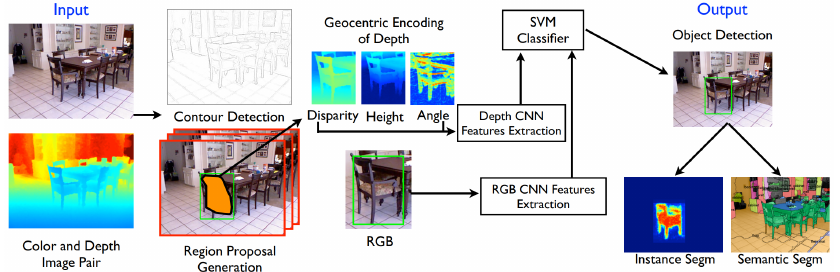
Figure 2. Pipeline for object detection and instance segmentation of RGB-D images. First a random forest classifier is used for contour extraction and a random forest regressor used for region proposals. HHA image channels are computed for the depth image and features extracted using a CNN. Simultaneously, RGB features are extracted using a CNN. All features are passed into a SVM for final classification. Foreground background segmentation is then applied for instance segmentation. Image source: